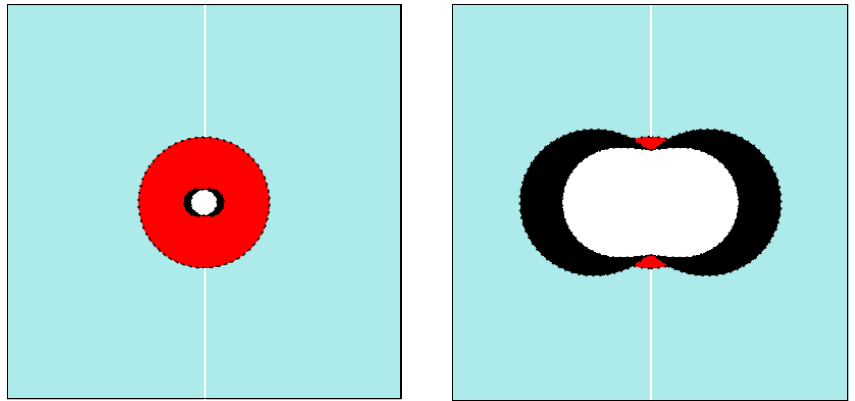
Figure 12 . Phase diagram for Euclidean modi(cid:12)ed (two boundary) single joining quench geometry with supercritical and subcritical L respectively. As before, the point ( x; y ) belongs to one of three regions, depending on whether the RT surface anchored at points f ( x; y ) ; ( (cid:0) x; y ) g is connected (red), disconnected and ending on the inner ETW brane (black), or disconnected and ending on the outer ETW brane (light blue).